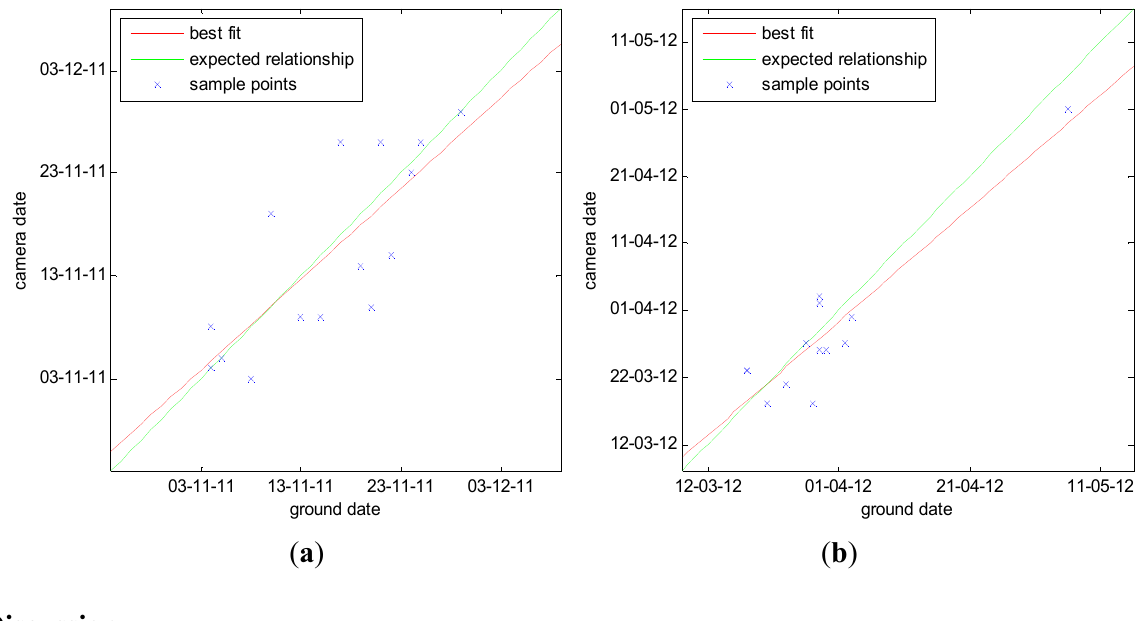
Figure 6. Ground truth dates versus dates automatically calculated from cameras; ( a ) end of senescence 2011; ( b ) start of green up 2012. Note: missing points are due to lack of camera data for visual